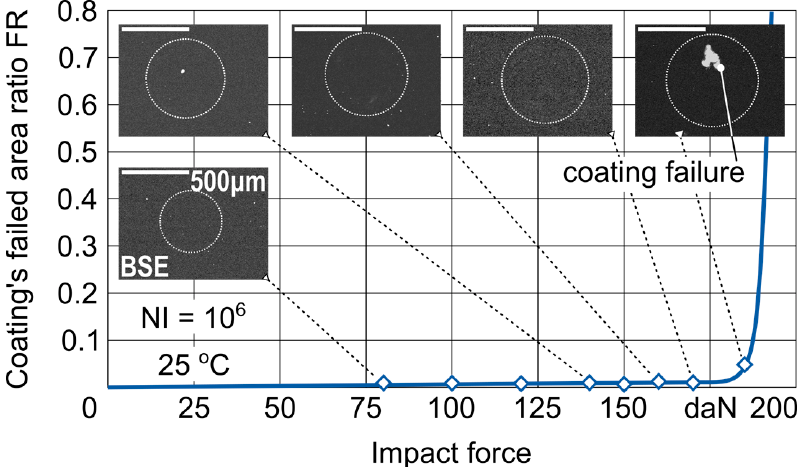
Figure 12. Impact test imprints on the DLC-coated HSS specimens and corresponding FRs at various impact forces after 10 6 impacts.